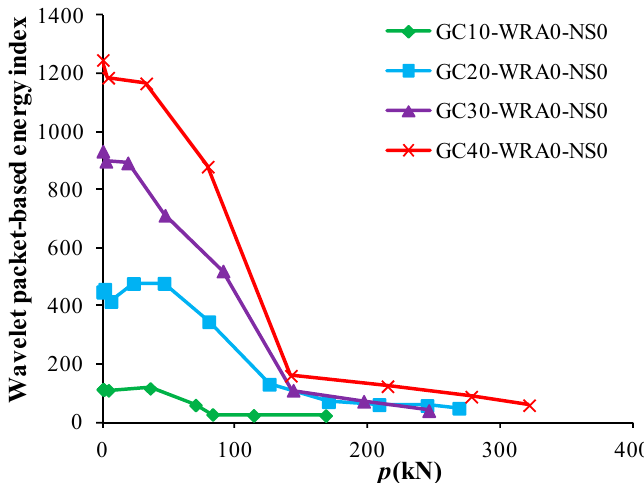
Figure 14. Load–energy index curves of specimens without superplasticizer at different concrete grades.